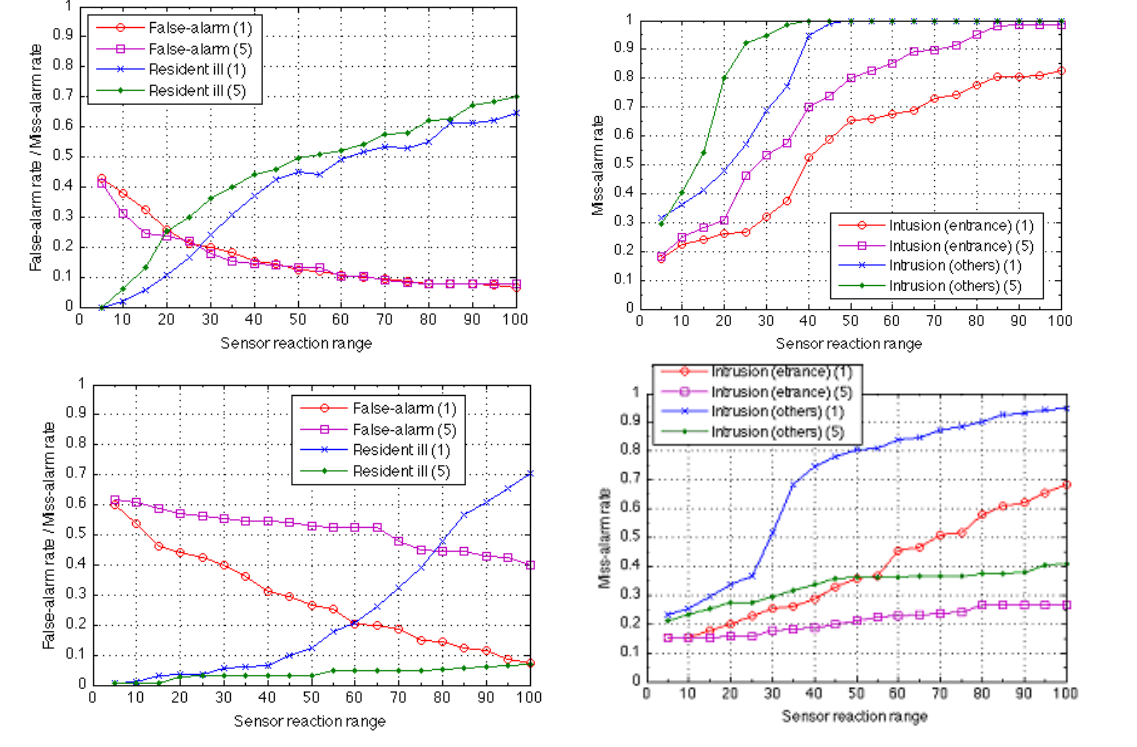
Figure 10. Average rates of false-alarms (left) and missed-alarms (right) of home A (above) and home B (below) when sensor sensitivity (sensor reaction range) is varied. The numbers in parentheses indicate the number of days used for training the system. In the left plots, the missed-alarm rate of the resident collapsing due to sudden illness (indicated by ―Resident Ill‖) is plotted in addition to the false-alarm rate of intrusion from the